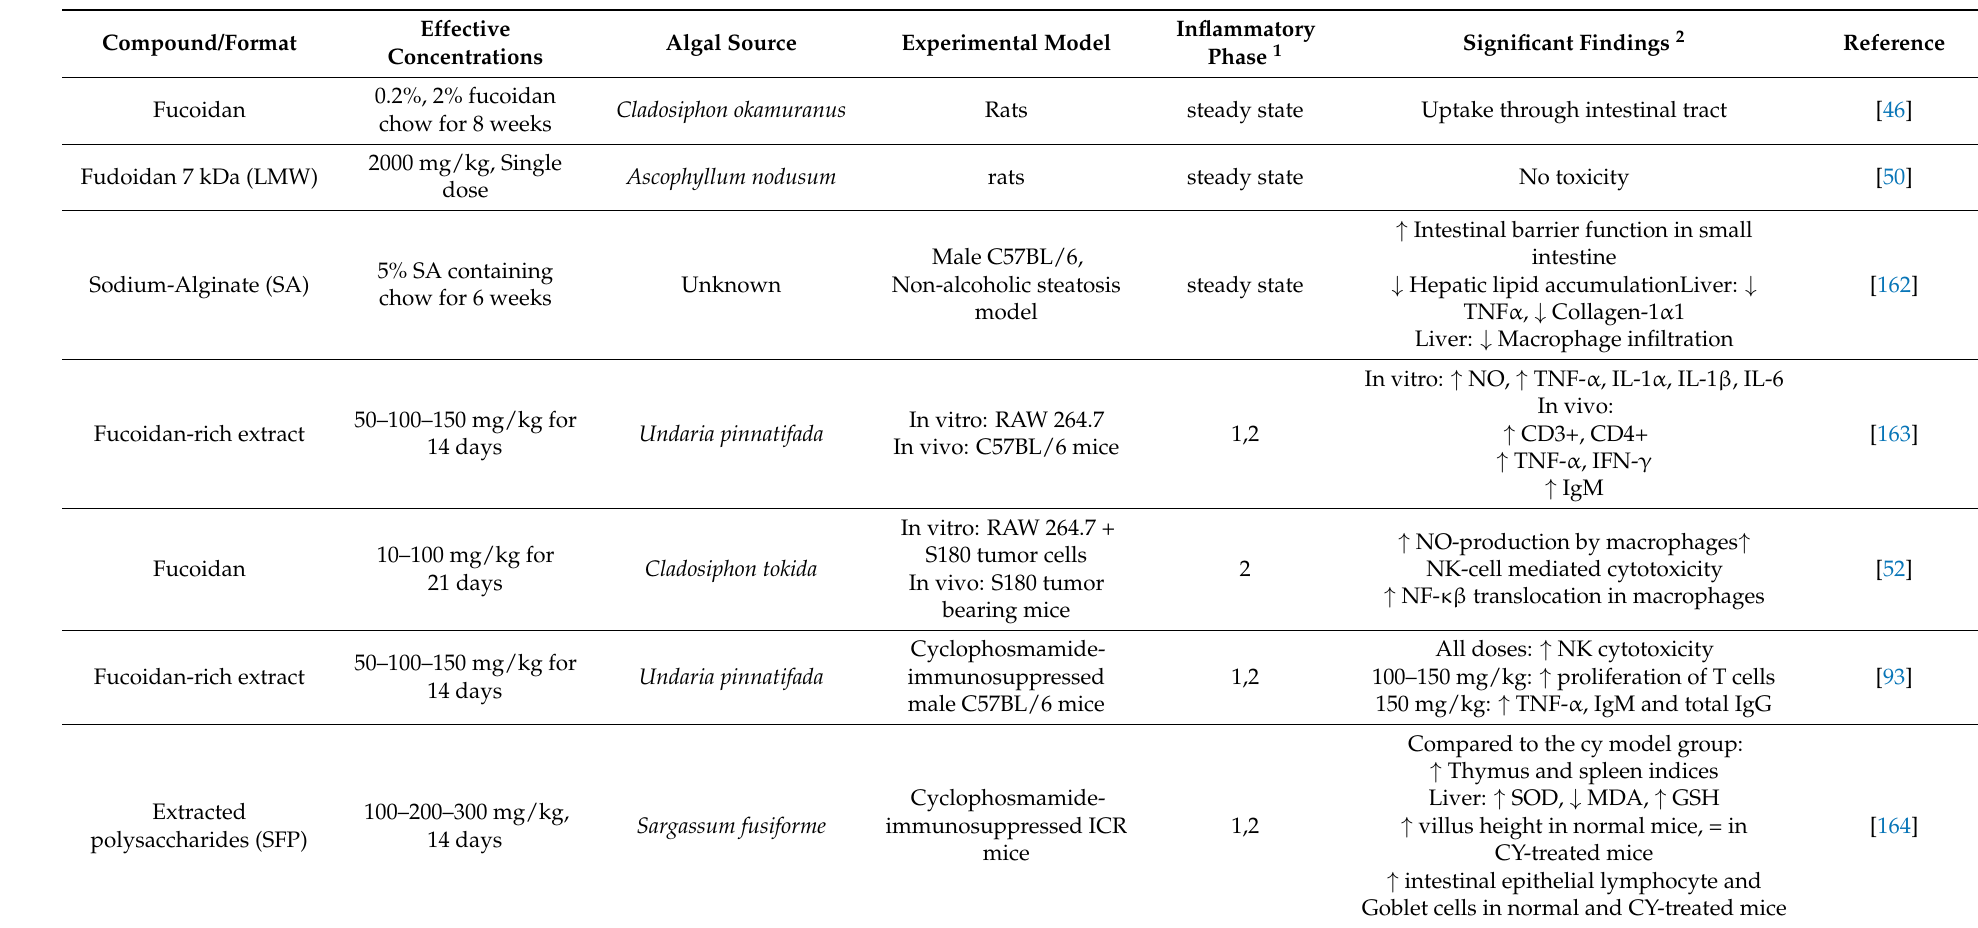
Table A2. Effects of oral supplementation of brown seaweed derived polysaccharides on inflammation-related